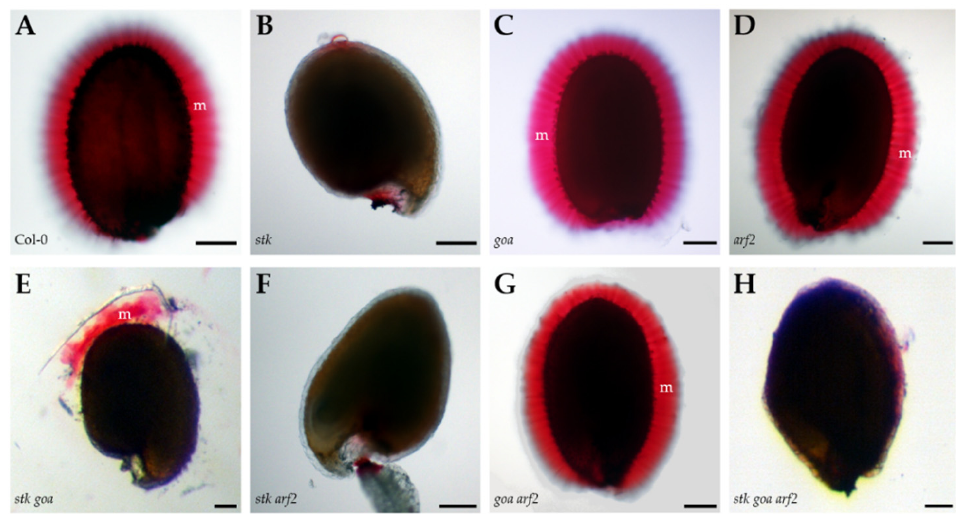
Figure 4. Mucilage extrusion assay. Wild type ( A ) and mutant mature seeds ( goa ( C ), arf2 ( D ) and goa arf2 ( G )) show mucilage-specific staining upon hydration and ruthenium-red treatment. Positive stain for pectin indicates the adherent mucilage layer. The cellulose network of the extruded mucilage and the more densely stained “rays” radiating from each columella can be seen. No capsule of mucilage is apparent on stk ( B ), stk arf2 ( F ) and stk goa arf2 ( H ) seeds stained after imbibition in water. Partial extrusion of adherent mucilage was observed on stk goa ( E ) seeds. For each one of the analyzed genotypes, n > 25 seeds were examined and a representative image of the phenotype is presented; WT (n = 28), stk (n = 25), goa (n = 29), arf2 (n = 30), stk goa (n = 20), stk arf2 (n = 26), goa arf2 (n = 28), stk goa arf2 (n = 27). Scale bar=100 μ m. m, mucilage.